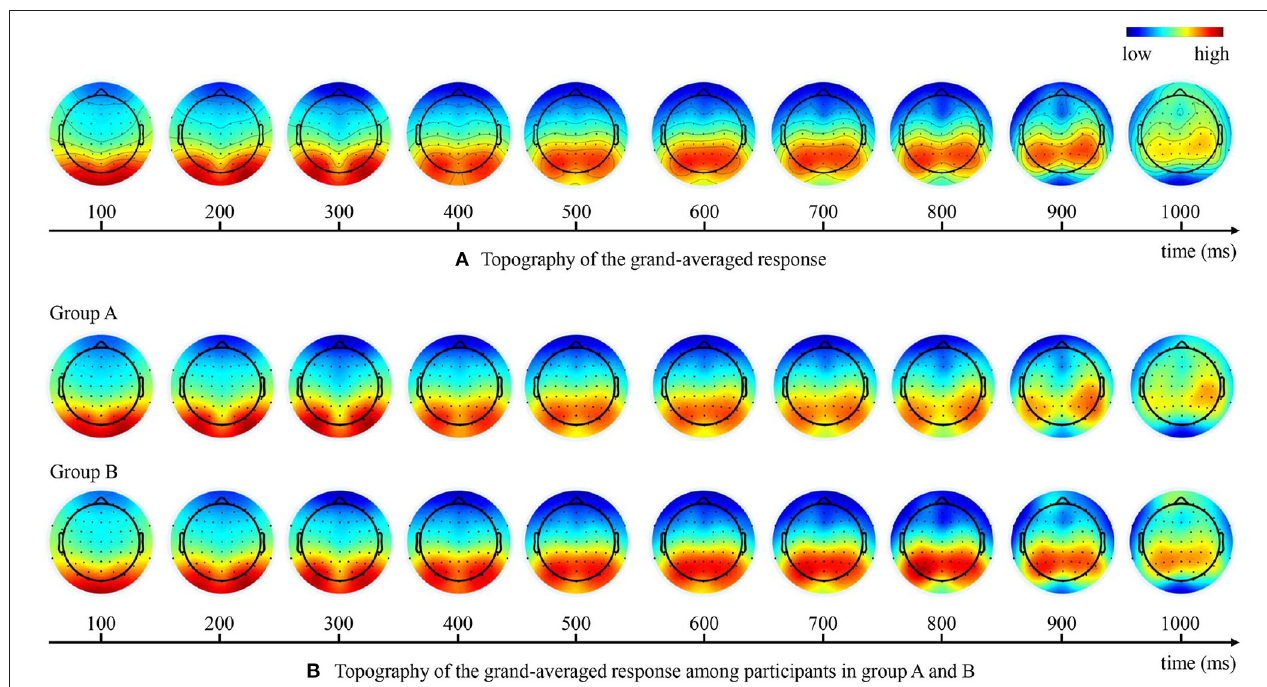
FIGURE 5 | Topography of the grand-averaged EEG response at different time points. (A) Brain response topographies of all participants. (B) Brain response topographies among participants in group A and